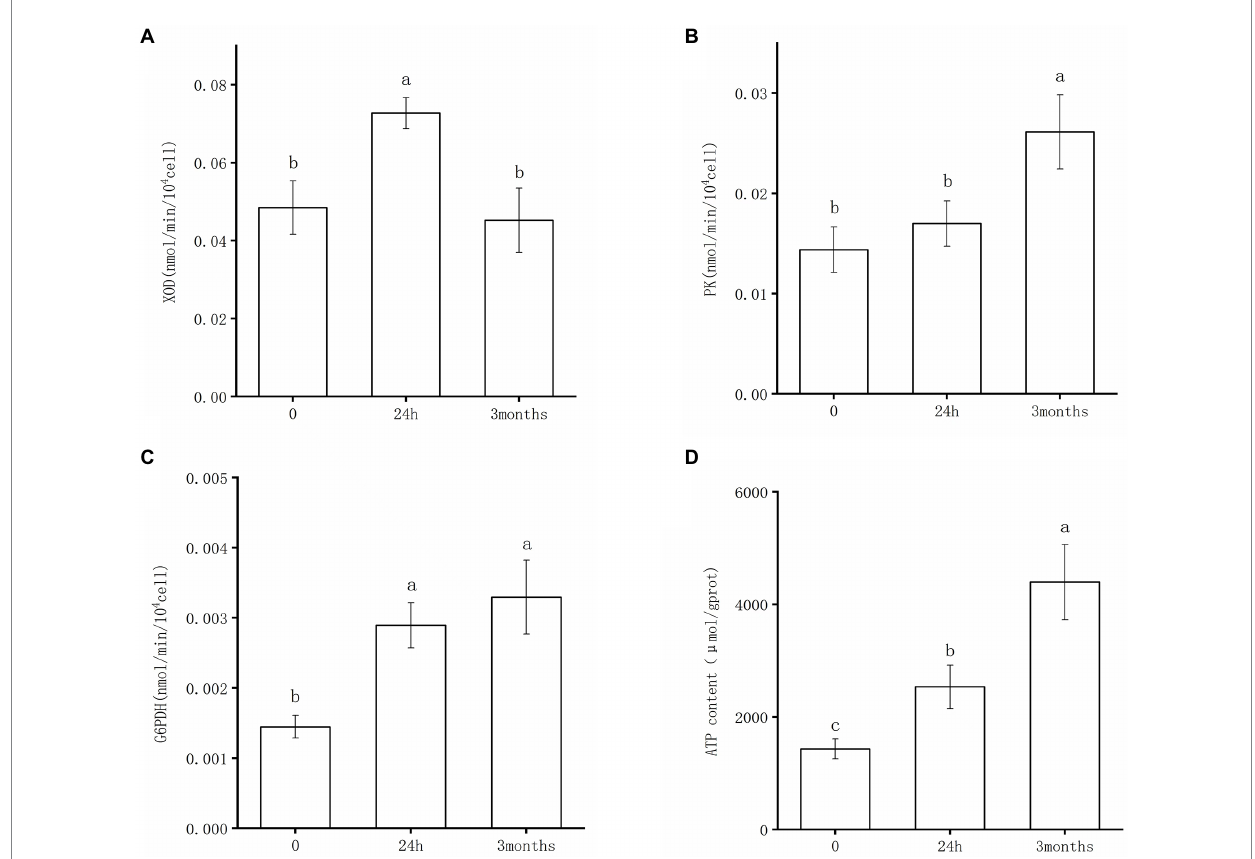
FIGURE 4 Enzyme activities of (A) XOD, (B) PK, (C) G6PDH, and changes of ATP content (D) after desiccation treatment and SMP storage. Different letters annotate significant difference in mean values ± standard deviations obtained from three independent tests ( p <